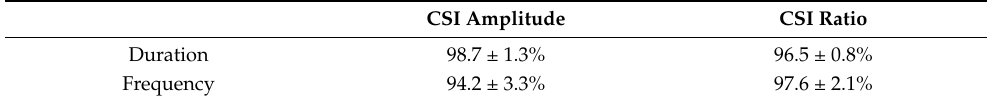
Table 5. A comparison of sensing accuracy when detecting hand resting tremor using CSI amplitude and CSI